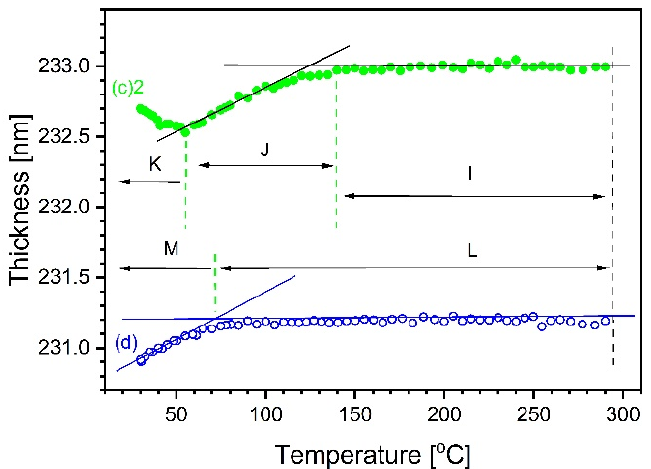
Figure 7. The 20% sample. Thickness variation as function of decreasing temperature in atmospheric